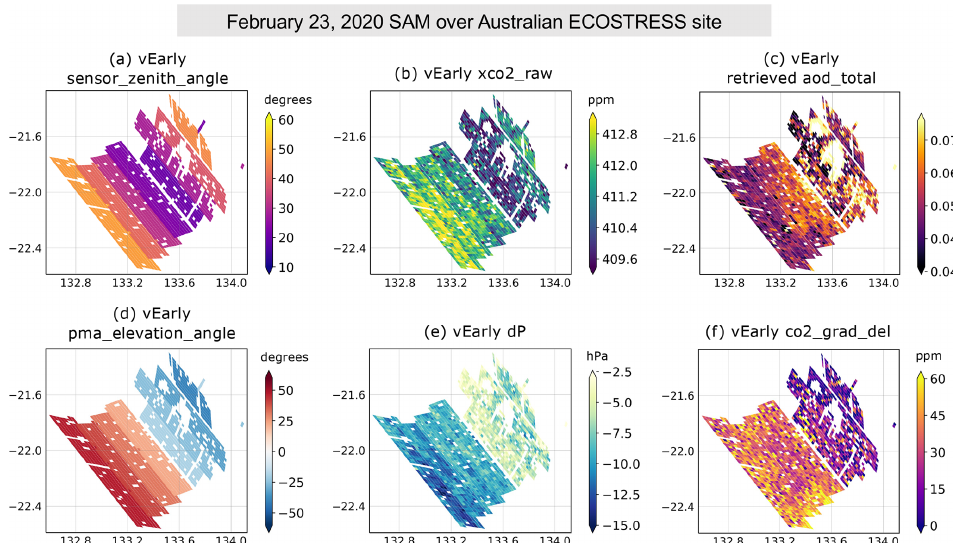
Figure 6. Maps of several retrieved and geometry-related parameters for a vEarly SAM over an Australian ECOSTRESS site on 23 February 2020.